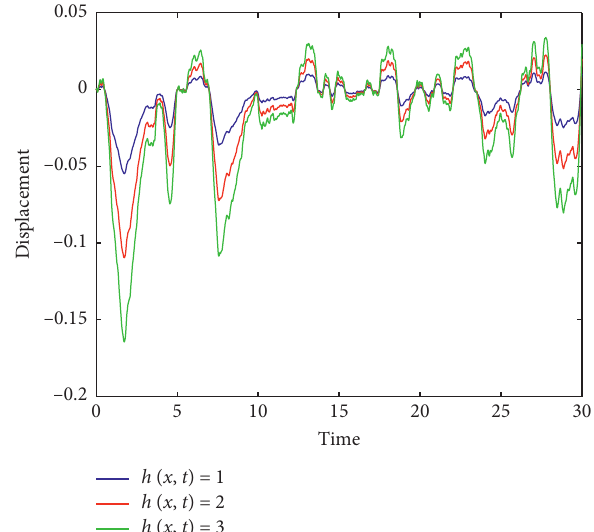
Figure 9: The horizontal displacement of 11 th story for the controlled case and for different values of h ( x,t )